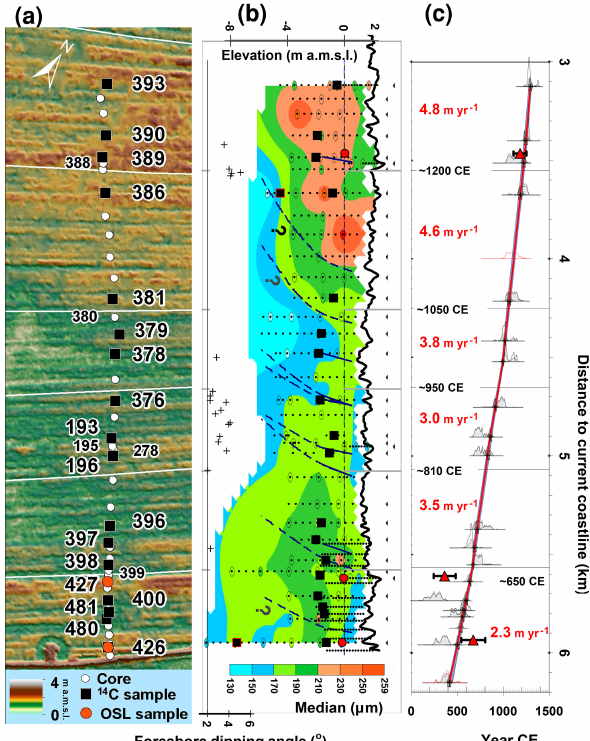
Figure 4. (a) Core locations along Transect A2; (b) median grain size of analysed sand samples with associated shoreface-dipping an- gle; (c) age–distance model (after Nooren et al., 2017) and OSL ages (red dots; with 1 σ